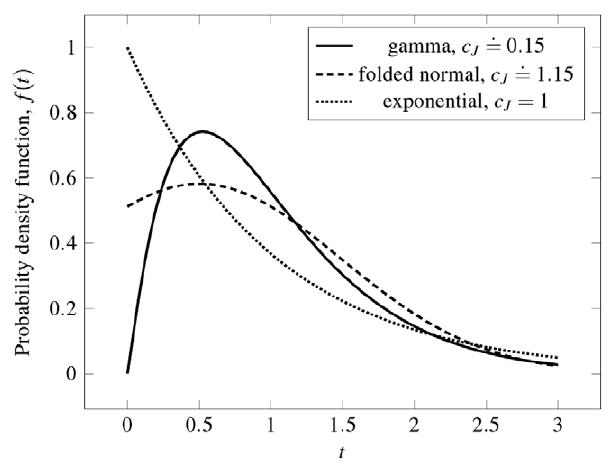
Figure 6. Comparison of probability density functions with E T ð Þ ~ 1 , identical c v and c h but different c J . For the gamma distribution holds c v ~ 0 : 69 , c h ¼ normal distribution holds c v ~ 0 : 69 , c h ¼ difference between these two distributions (from the c J point of view) lies in the initial slope of the gamma probability density. For comparison, the exponential density ( c v ~ c h ~ c J ~ 1 ) is shown.